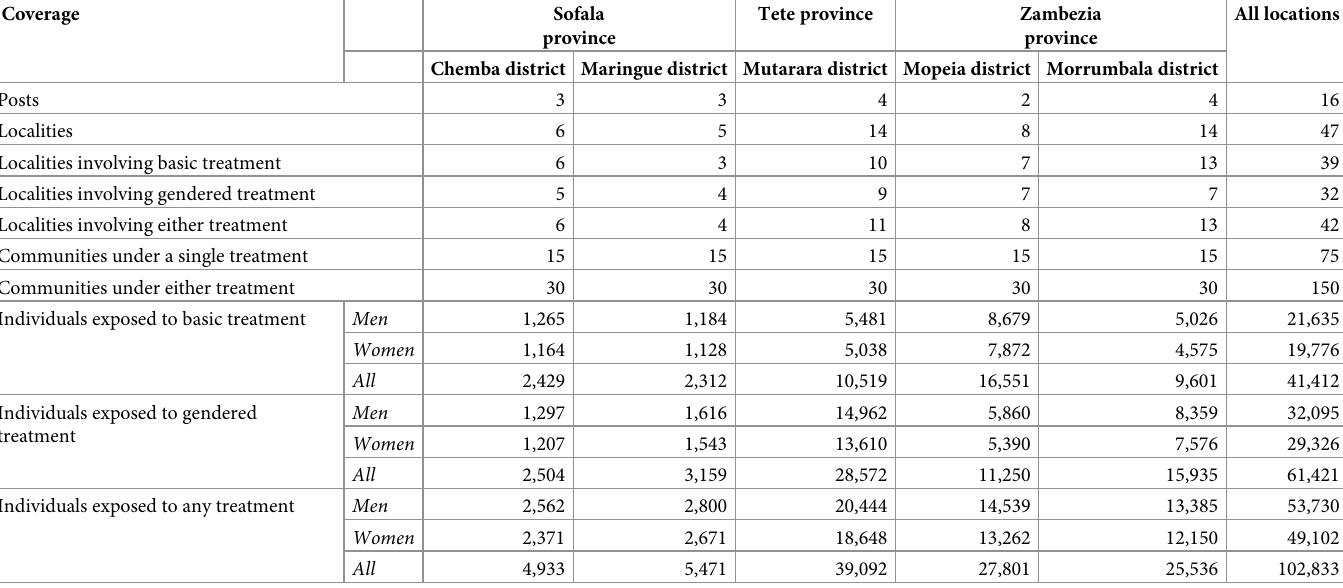
Table 3. CGAAS: Coverage of the agricultural advisory services programme in Mozambique.